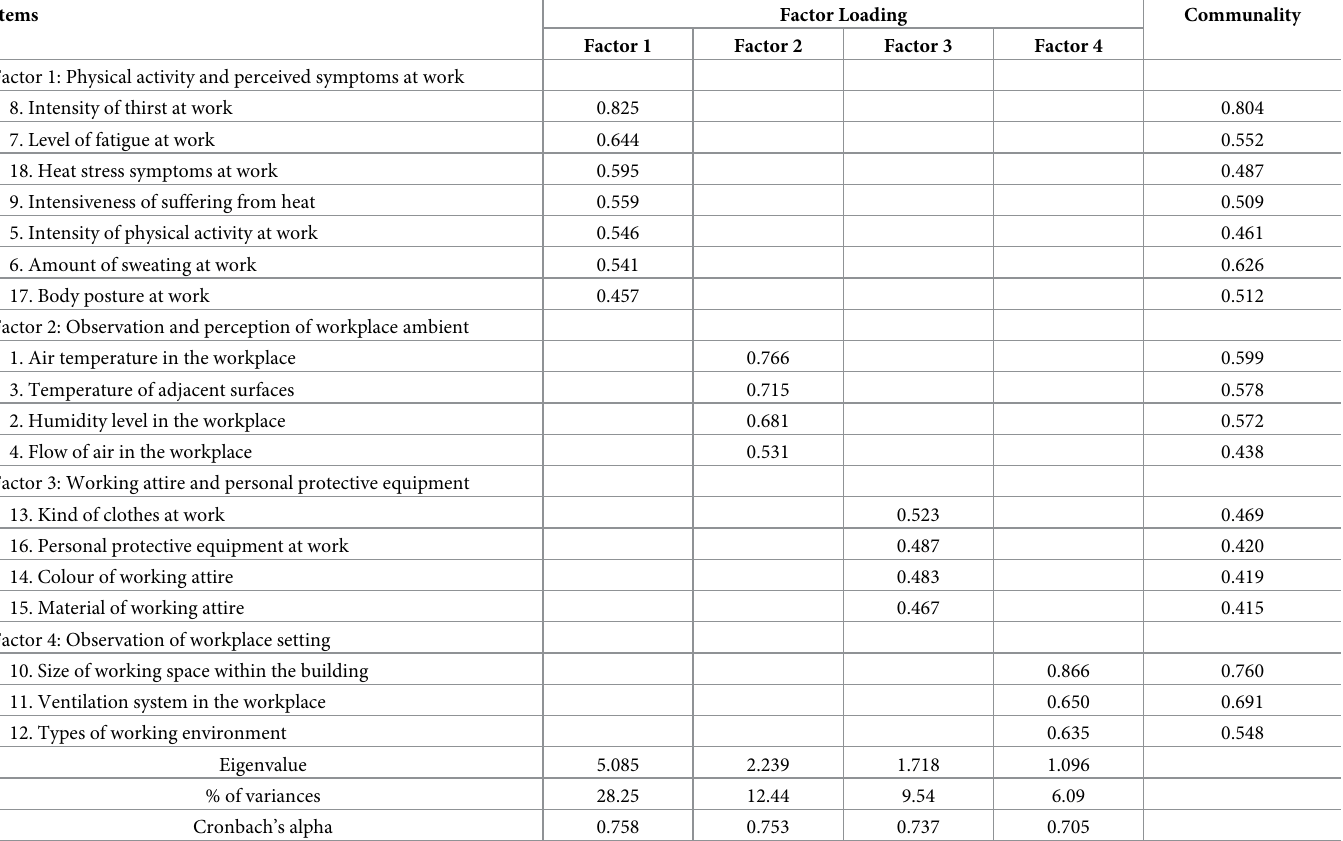
Table 5. Factor loadings and communalities based on the principal axis factoring with varimax rotation for 18 items and Cronbach’s alpha on the HSSI-Malay ver- sion questionnaire (N = 188).